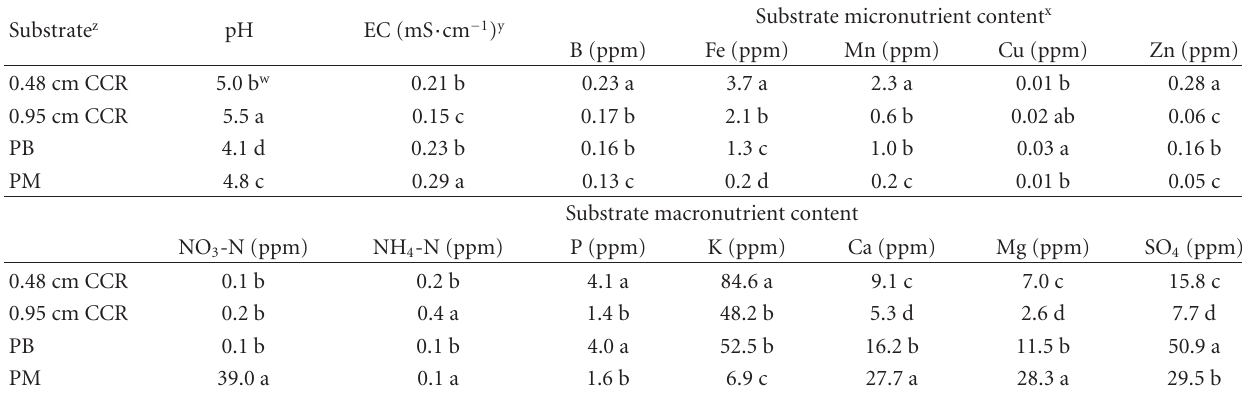
Table 3: Chemical properties of clean chip residual, pine bark, and peatmoss